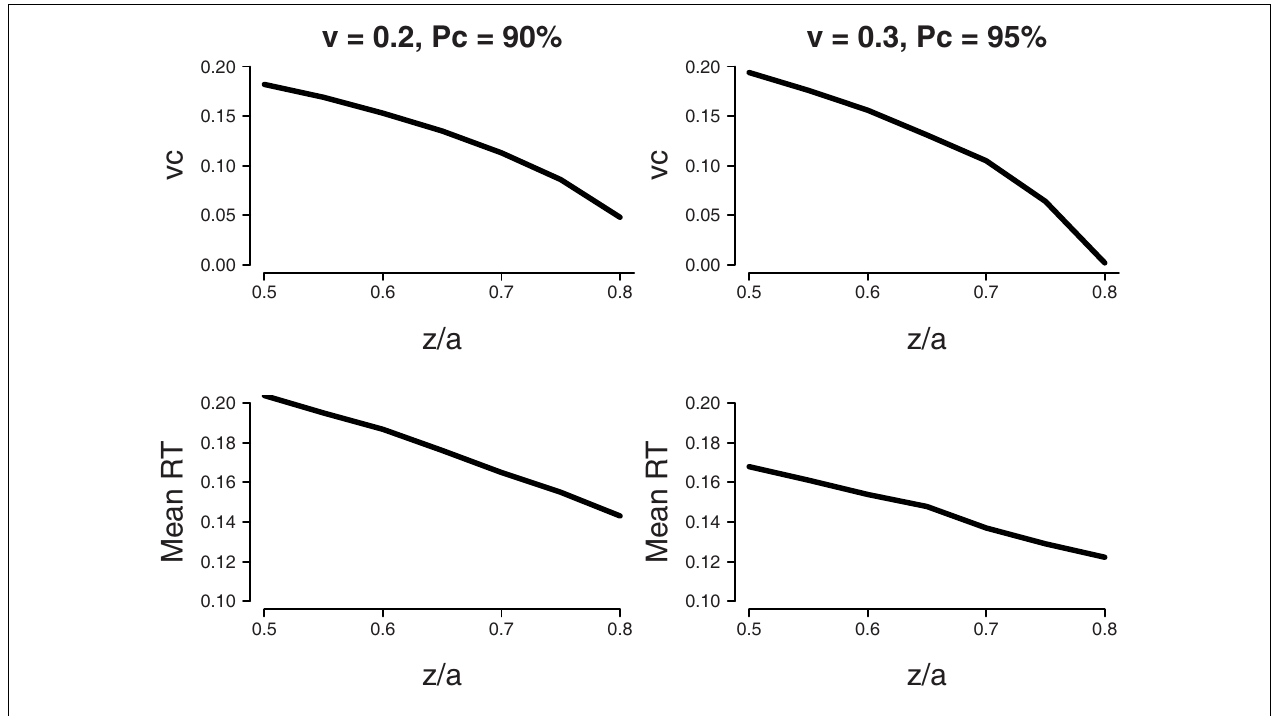
boundary separation z / a and shift in drift rate criterion v c that lead to the same fixed level of accuracy (90% for v = 0.2, 95% for v = 0.3). Bottom panel: Mean RT that corresponds to the parameter combinations of the top